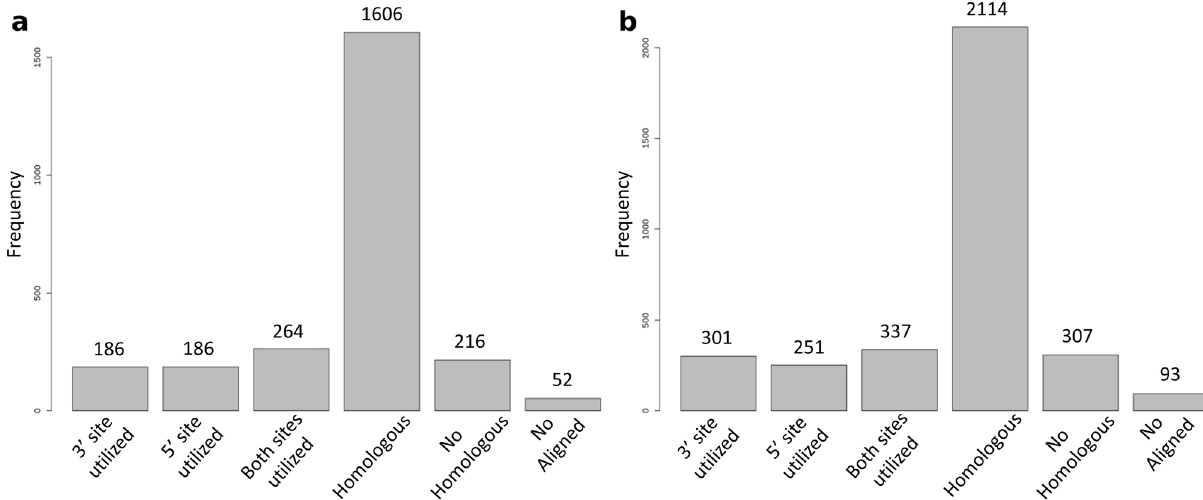
Figure 3. Bar plot with the result of the conservation analysis. In the x-axis the different categories described in “Material and methods” and in the y-axis the number of circRNAs in each category. ( a ) Encephalon; ( b ) PBMCs.